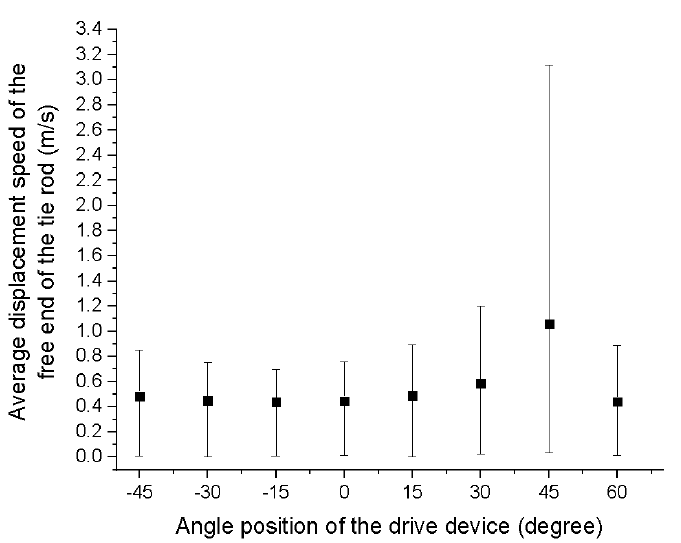
Figure 11. Variation of the average value of the free end speed of the tie rod as a function of the positioning angle of the drive device.